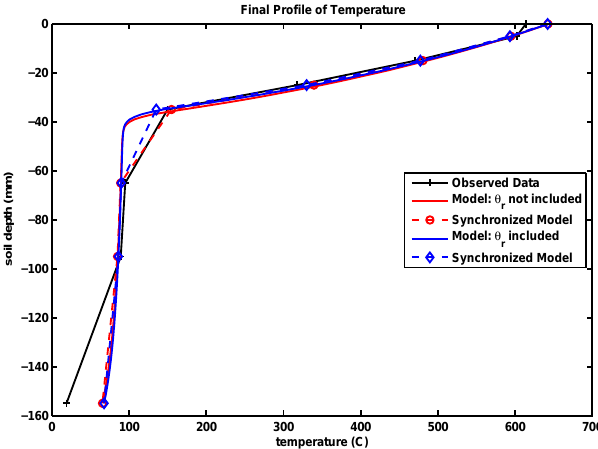
Figure 12. Modeled soil moisture vs modeled soil temperatures for the Palousse B Wet heating experiment (see Figs. 10 and 11 above). The solid lines are for a model simulation that does not include the dynamic residual soil moisture, θ r ; the dotted lines correspond to a simulation that includes θ r . This is the solution space representation of the model’s solutions.